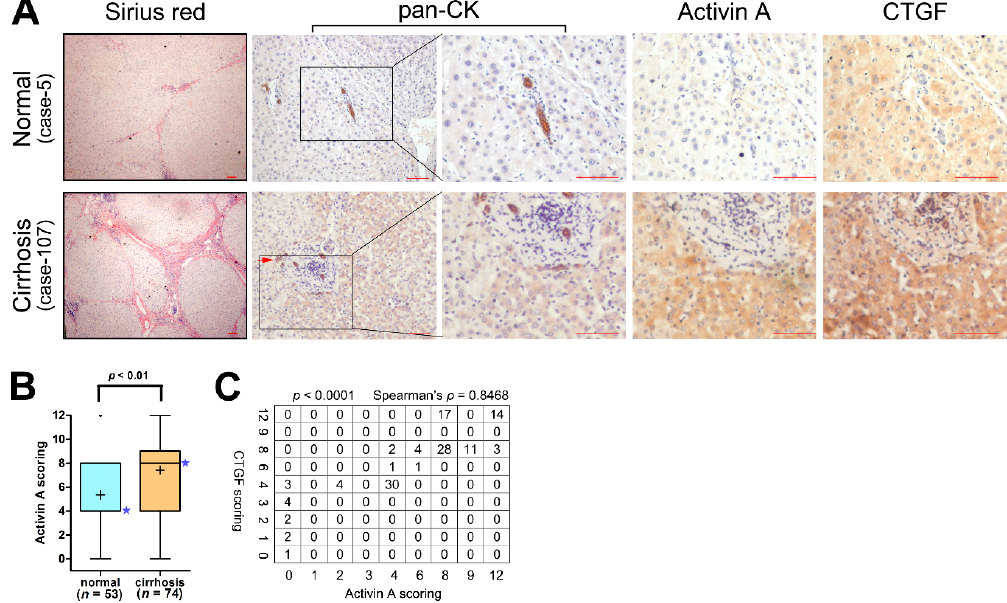
Figure 1. The expression of Activin A and connective tissue growth factor (CTGF/CCN2) were elevated in the cirrhotic liver. ( A ) Serial sections of human liver samples were subjected to Sirius red staining and immunohistochemical analysis of pan-cytokeratin, Activin A and CTGF/CCN2. Representative images were shown, LPC pools in the liver were indicated by the red arrow. The length of the scale bar in the lower right corner of every image is 100 μ m; ( B ) Liver sections were divided into two groups: normal group and cirrhosis group according to the Histology Activity Index (HAI) score system. The immunohistochemistry score of Activin A in each immnuostained liver section was evaluated. The expression of Activin A in each group was shown, the pentagram indicated the median score of each group. Wilcoxon test, p < 0.01; ( C ) Correlation of expression levels